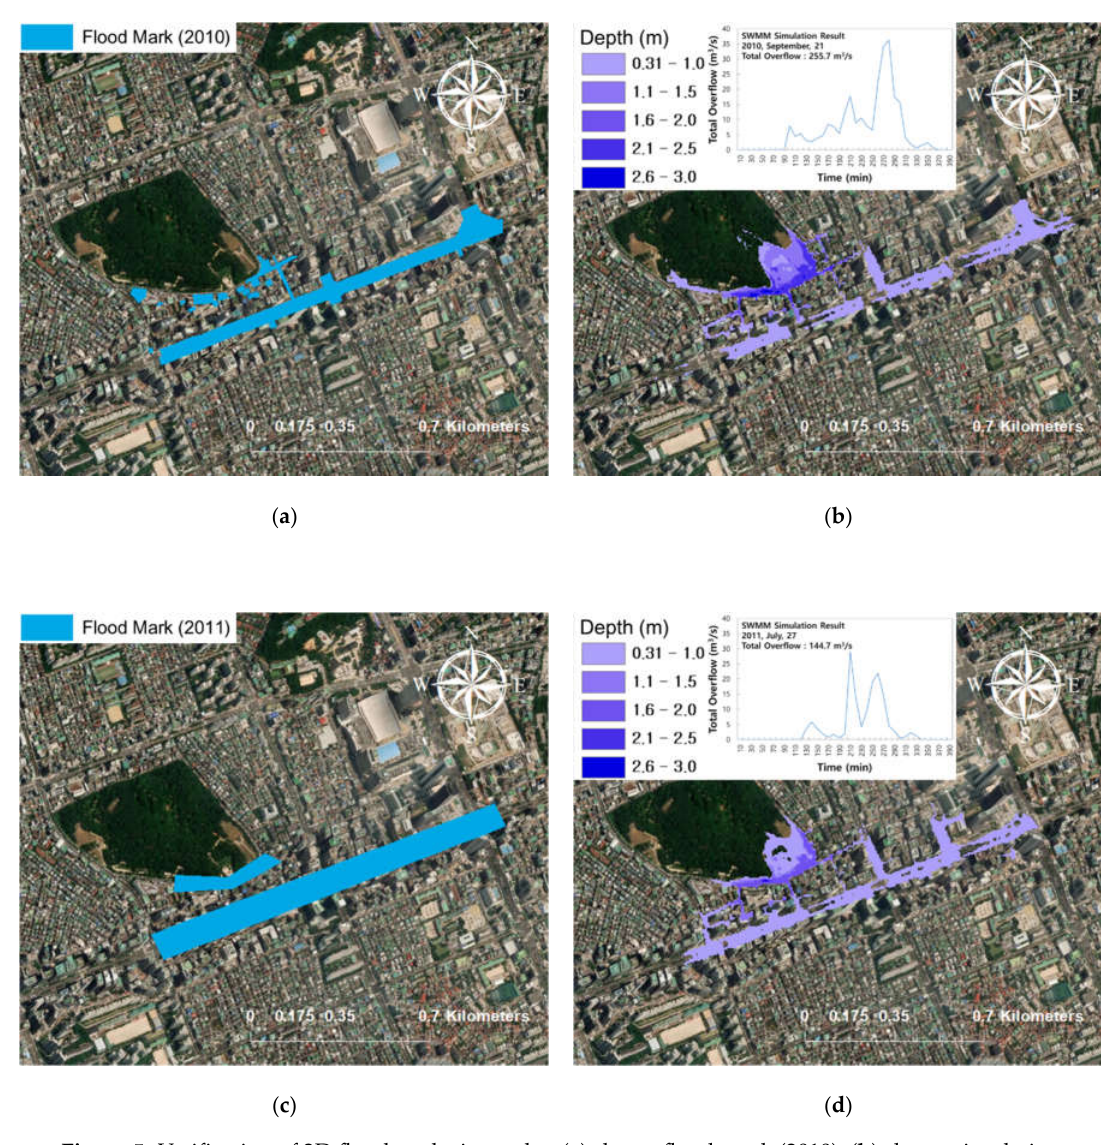
Figure 5. Verification of 2D flood analysis results. ( a ) shows flood mark (2010), ( b ) shows simulation result (21 September 2010), ( c ) shows flood mark (2011), and ( d ) shows simulation result (27 July 2011).